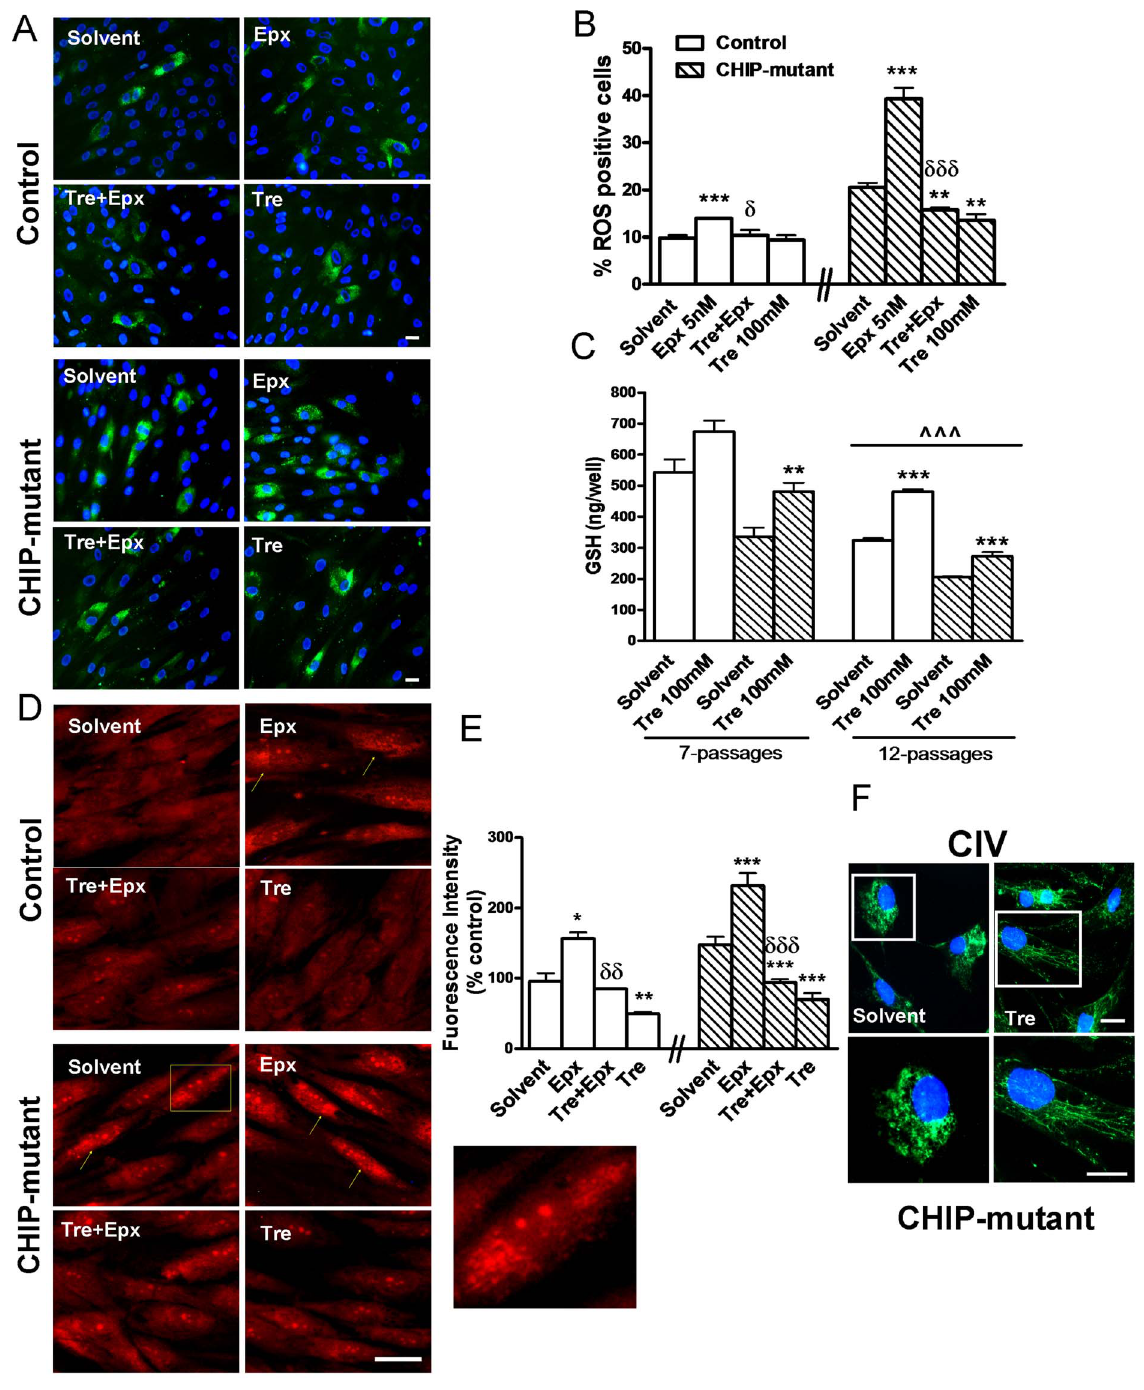
Figure 3. ROS production, Glutathione homeostasis and Mitochondrial membrane potential. A ) Representative images of DCF staining in control and CHIP-mutant fibroblasts for the indicated treatment. Scale bar =10 m m. B ) Percentage of DCF positive fibroblasts. One hundred fifty to two hundred cells per coverslip cells were counted. C ) GSH levels in control and CHIP mutant human fibroblasts with 7 and 12 passes. D ) Representative images of MitoTracker TM Ros and nuclei Hoescht staining in control and CHIP-mutant fibroblasts cultured in the presence of epoxomicin (10 nM) and/or trehalose (50 mM). Yellow arrows indicate small depolarized mitochondria (scale bar =30 m m). E ) Quantification in IOD of fibroblasts with altered mitochondria morphology by fluorescenceimaginganalysisin10randomfieldsof6coverslipsfromcontrolandCHIP-mutantcultures(Scalebar =15 m m). F )ComplexIVstainingshowedan abundant and granular perinuclear pattern indicating mitochondrial compartmentalization (scale bar =10 m m). A cell of this micrograph has been magnified in the pictures below. Data of the control and CHIP-mutant groups were analyzed independently, no inter-group statistical analysis was performed. Data are expressed as the mean 6 SEM. Values of 3B are the mean of two independent experiments of 4 independent cell dishes ‘‘n=4’’ (pseudo-replicates) of the patient group and in control group ‘‘n=2’’: the mean of 2 different controls with 4 dishes of cells each one. In 3C and 3E values are the mean 6 SEM from two experimentswith6independentcellsdishes(n=6,pseudo-replicates).StatisticalanalysiswasperformedbyStudent’st-test.*p , 0.01,**p , 0.01,***p , 0.001vs solvents; d p , 0.05, dd p , 0.01, ddd p , 0.001 trehalose + epoxomicin vs epoxomicin treated cultures; ‘‘‘ p , 0.001 fibroblasts with 12 vs 7 passages.